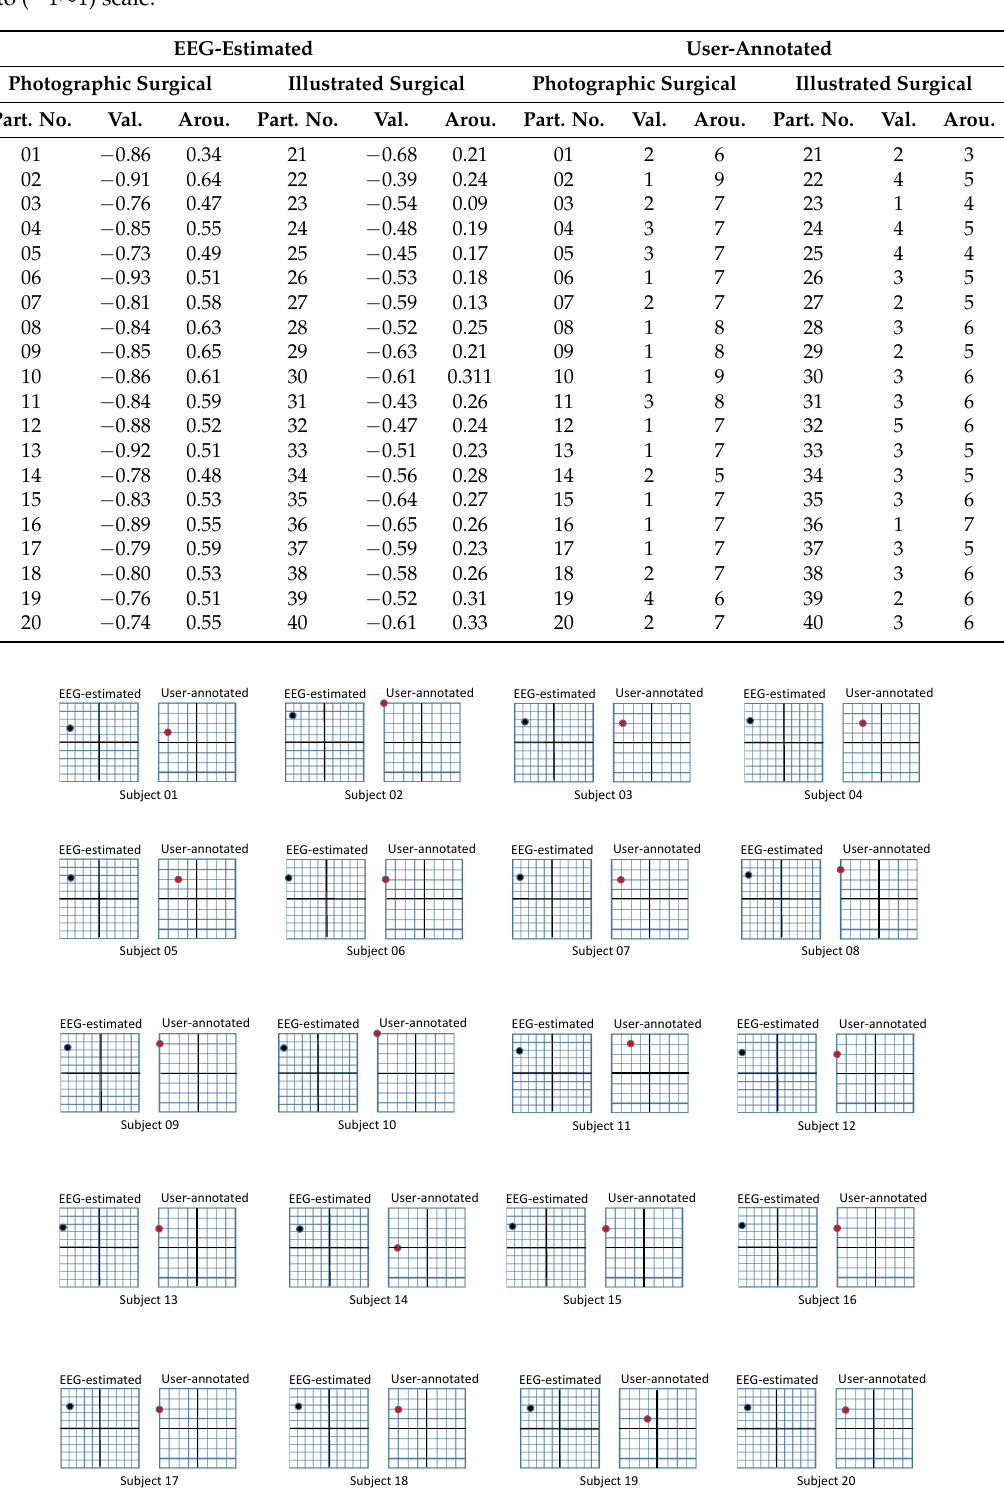
Figure 8. Results from photographic surgical images. Subjects 01 ∼ 20 participated in the experiment for photographic surgical images. The left box, which corresponds to EEG-based recognition has a range of ( − 1,1 ) × ( − 1,1 ) , while the right box corresponding to user-annotated emotion has a range of ( 1,9 ) × ( 1,9 ) . The x-axis of each box represents valence and the y-axis represents